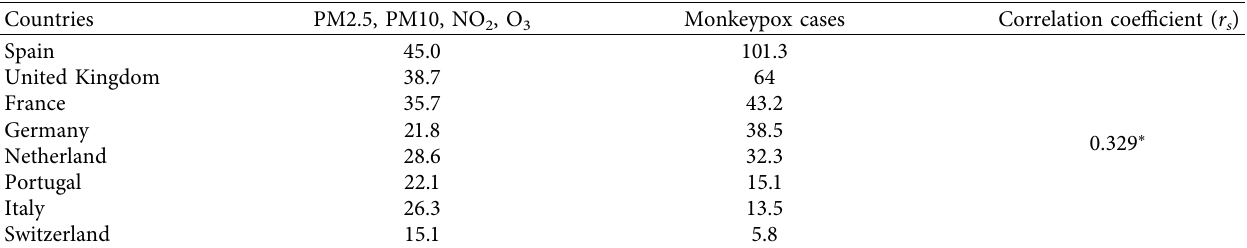
2 , O 3 , and monkeypox cases in European countries.